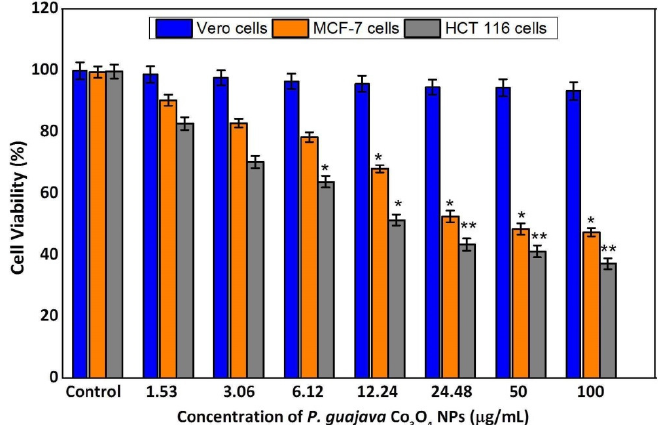
Figure 10. Cytotoxicity assay of green synthesized Psidium guajava Co 3 O 4 NPs against Vero cells, MCF-7 cells, and HCT 116 cells. P. guajava Co 3 O 4 NPs reduced the cell viability in a dose-dependent manner. Vero cells, MCF-7 and HCT 116 cells were treated with P. guajava Co 3 O 4 NPs at different concentration (1.53, 3.06, 6.12, 12.24, 24.48, 50 and 100 μ g/mL) for 24 h. Results are represented as mean ± SD, triplicate measures. * p < 0.05, ** p < 0.01.